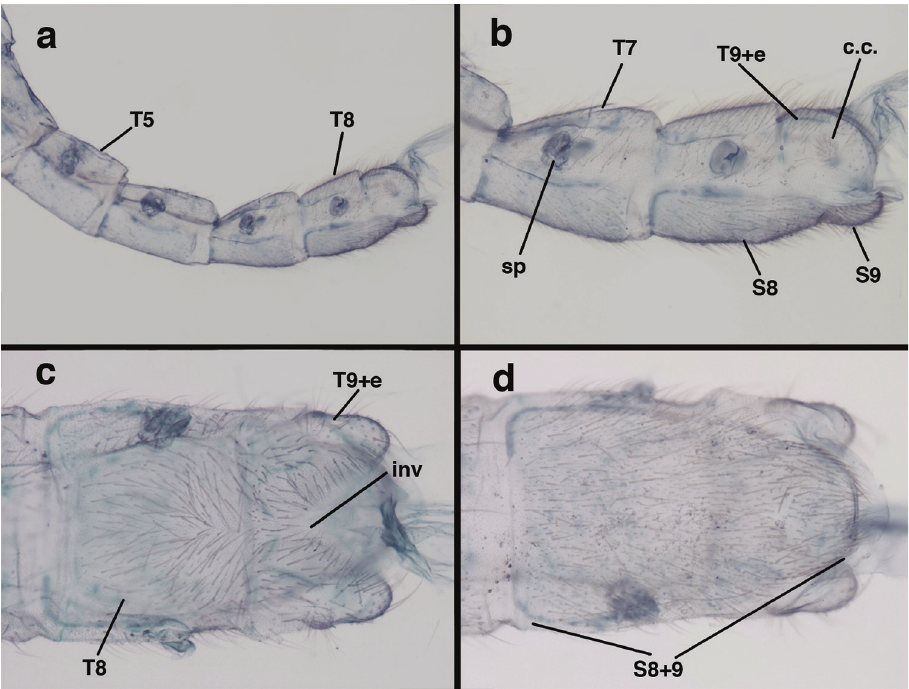
Figure 24. Ungla curimaguensis Sosa: Slightly teneral male abdomen, ( a ) segments A5-terminus, lat- eral ( b ) segments A7-terminus, lateral ( c ) eighth tergite and fused ninth tergite+ectoproct, dorsal ( d ) fused sternites 8+9, ventral. c.c. callus cerci, inv dorsal invagination of T9+ectoproct sp spiracle T5, T7, T8 fifth, seventh, eighth tergites T9+e fused ninth tergite and ectoproct S8, S9 eighth, ninth sternites (all: Venezuela, Mérida,